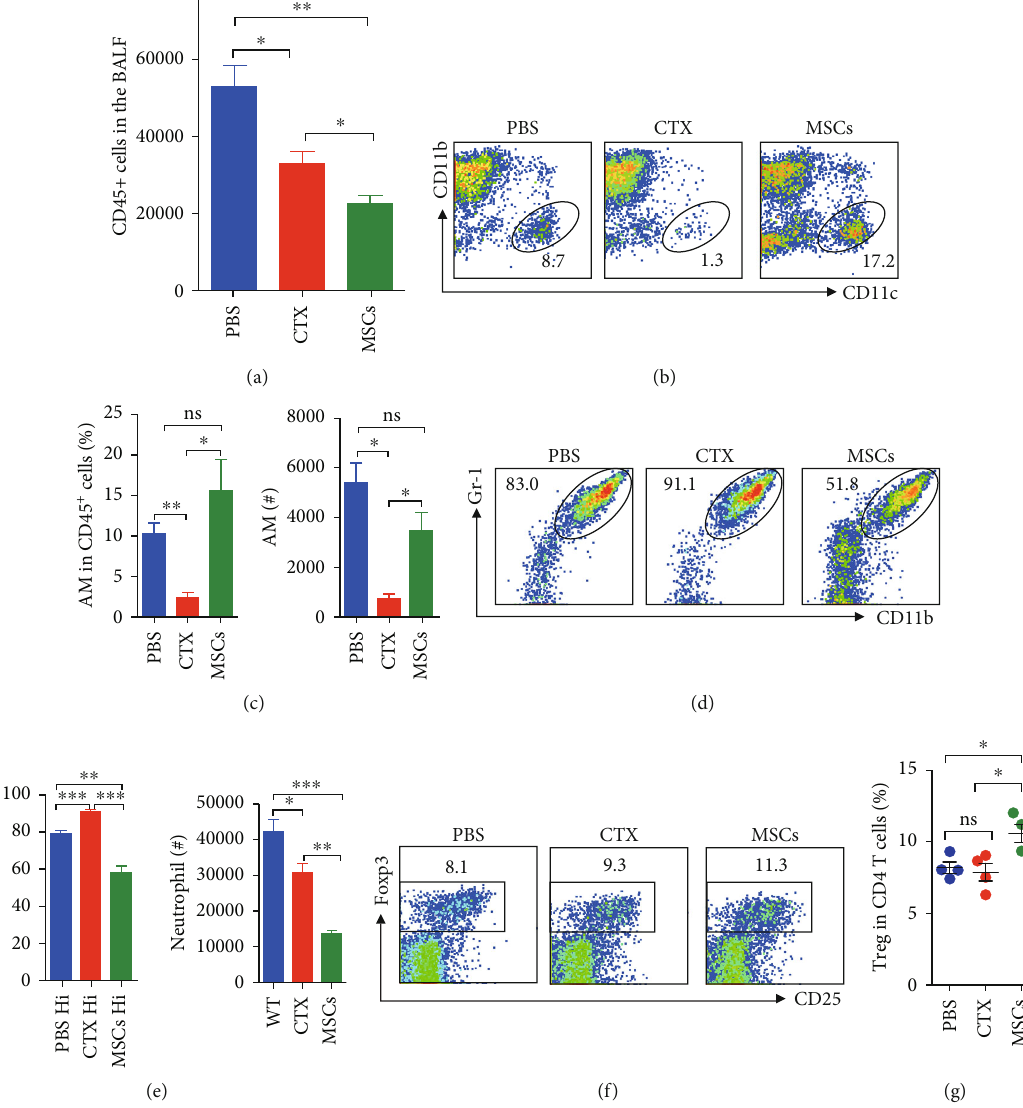
Figure 6: Mice treated with MSCs had fewer neutrophils but more alveolar macrophages in the lung after infection. Mice treated with MSCs or CTX were infected with Hi and sacri fi ced as described above. BALF cells were collected for analyses. (a) The number of BALF CD45 + cells (leukocytes). (b, c) Alveolar macrophages (CD11b - CD11c + ) and (d, e) neutrophils (CD11b + Gr-1 + ) were determined by surface staining, and both their percentages of leukocytes and absolute numbers were shown. (f, g) Tregs in the lungs were determined by intracellular staining. Data were expressed as the means ± SEM . n = 4 mice for each treatment group; ∗ p < 0 : 05 ; ∗∗ p < 0 : 01 ; ∗∗∗ p < 0 : 001 ; ns: no signi fi cant di ff erence. This experiment is representative of three individual